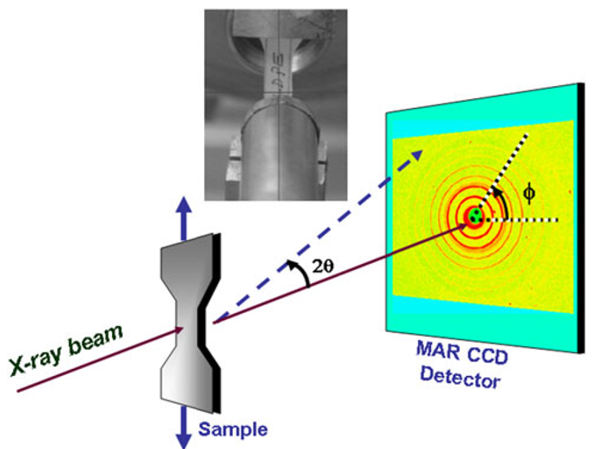
Figure 11: Experimental setup for In situ small-angle x-ray scattering